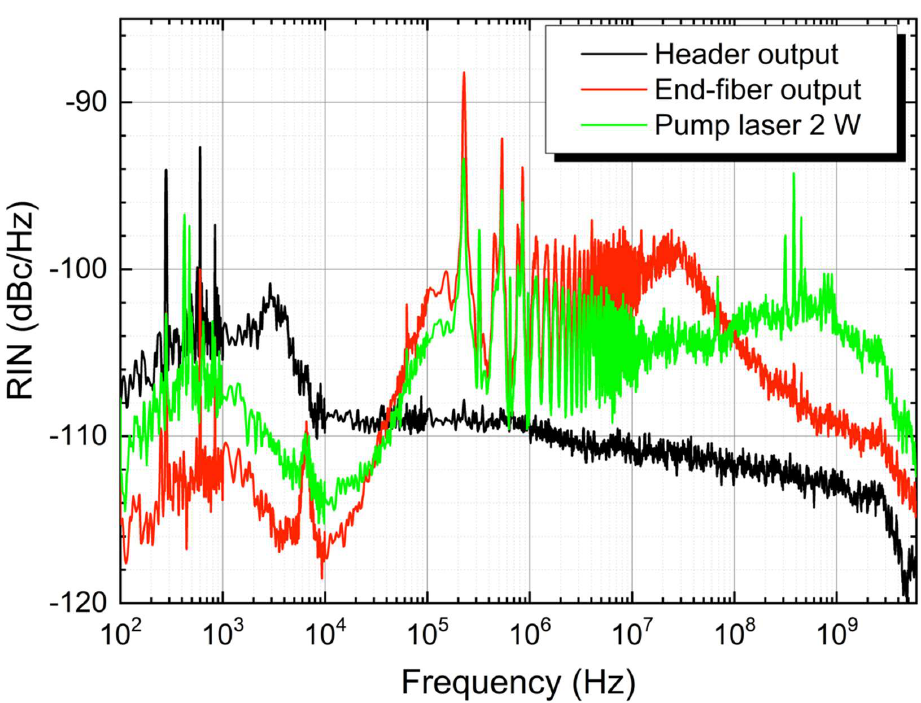
Figure 3 . RIN measurements of the RDFL at the end-fiber (red) and header (black) outputs, and the RIN of the pump (green), for a 0.3 nm BW and 2 W pump power .